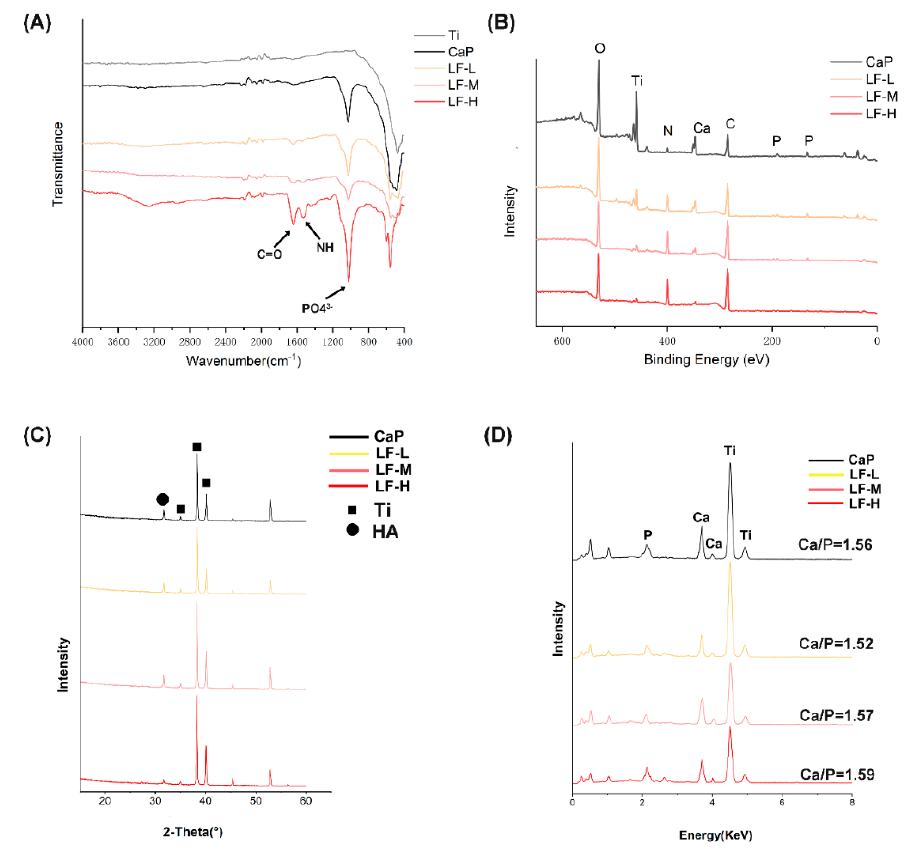
Figure 2. ( A ) FTIR spectra of Ti, CaP, LF-L, LF-M, and LF-H; ( B ) XPS spectra of CaP, LF-L, LF-M, and LF-H; ( C ) XRD spectra of Ti, CaP, LF-L, LF-M, and LF-H; ( D ) EDX spectra and Ca/P ratios of Ti, CaP, LF-L, LF-M, and LF-H.